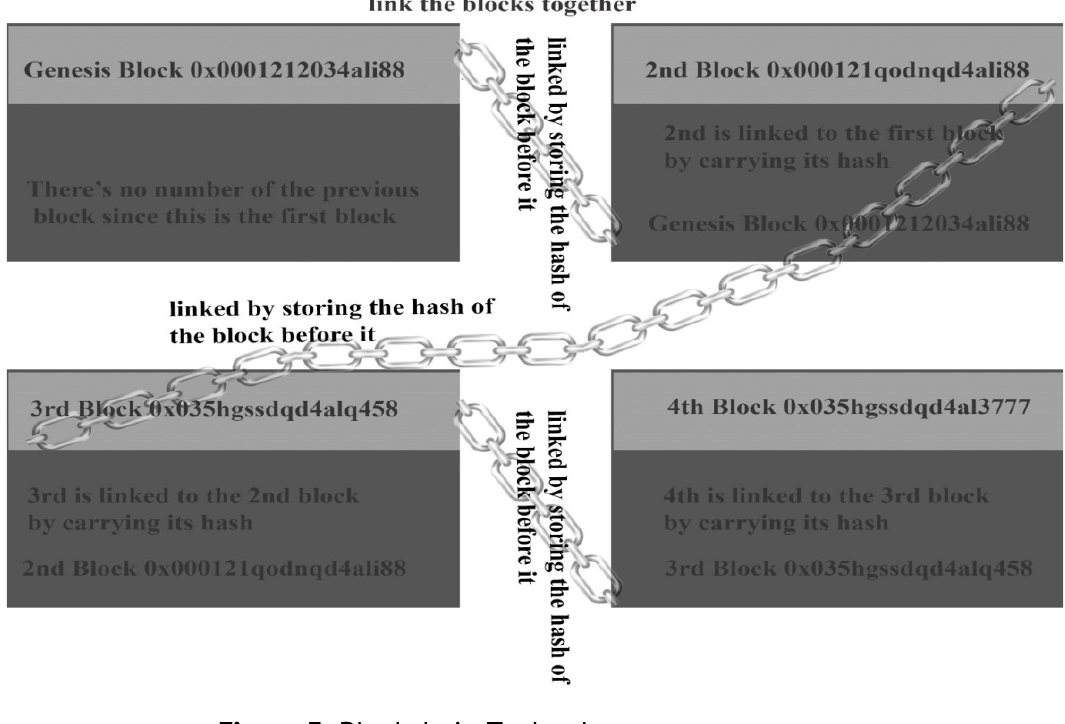
Figure 3. Blockchain Technology